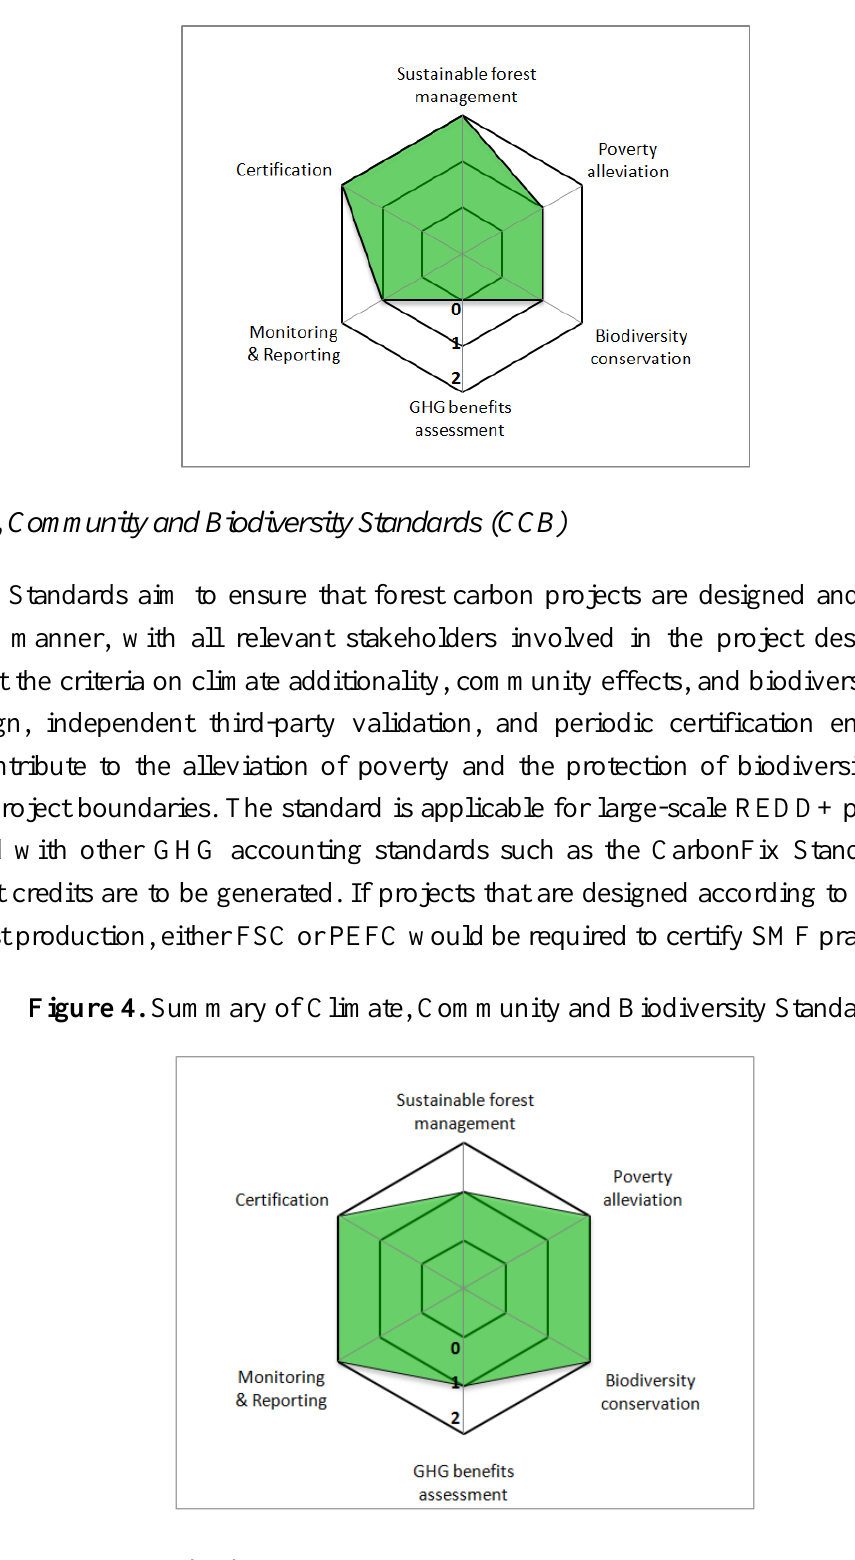
Figure 3. Summary of Programme for the Endorsement of Forest Certification (PEFC).